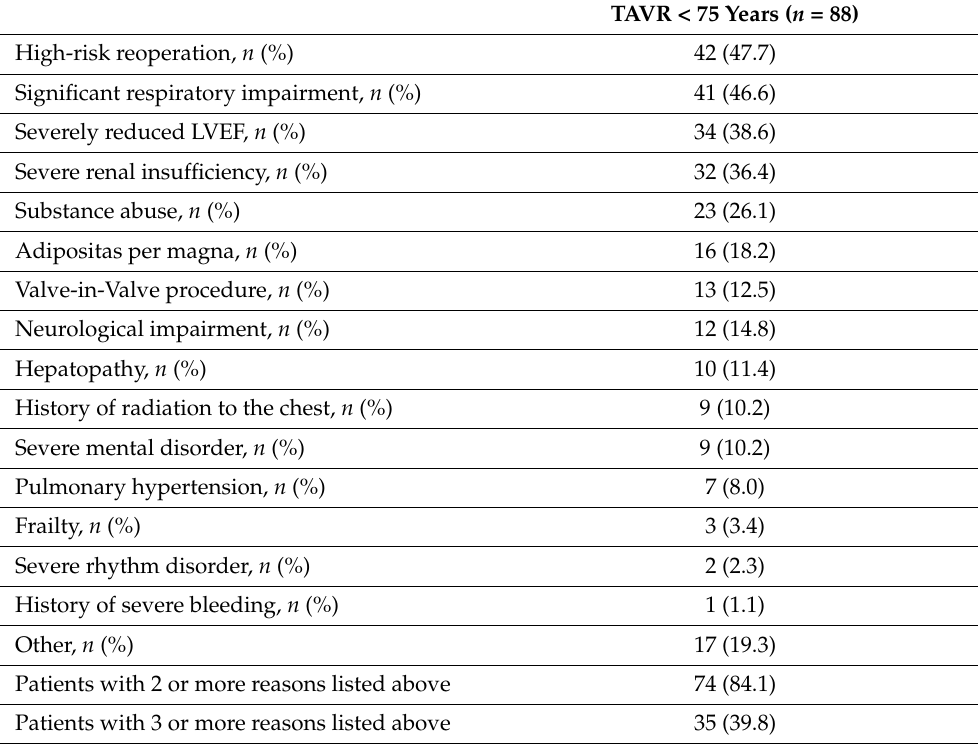
Table 3. Determining factors forthe choice ofTAVR over iSAVR, as documented by the Heart